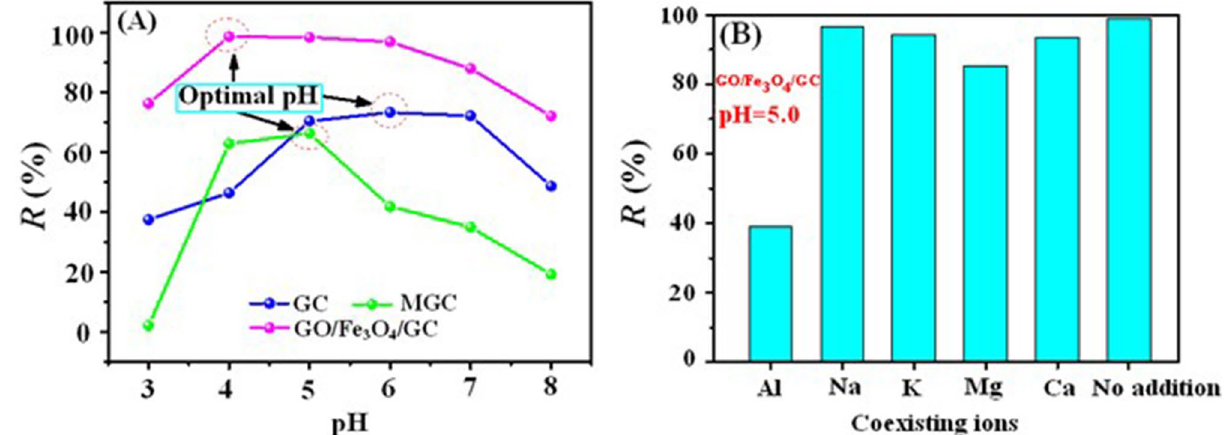
Figure 5. Effect of pH ( A ) and co-existing ions ( B ) on the U(VI) adsorption. C (U)initial = 10 mg L −1 ,